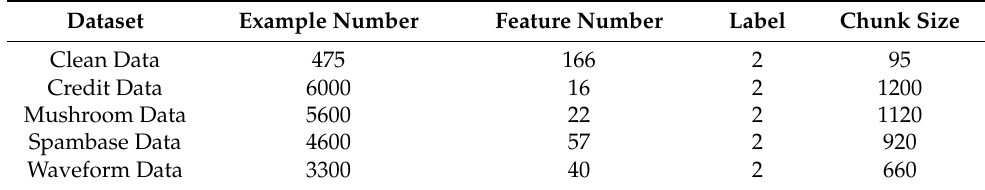
Table 2. Concept drift of real